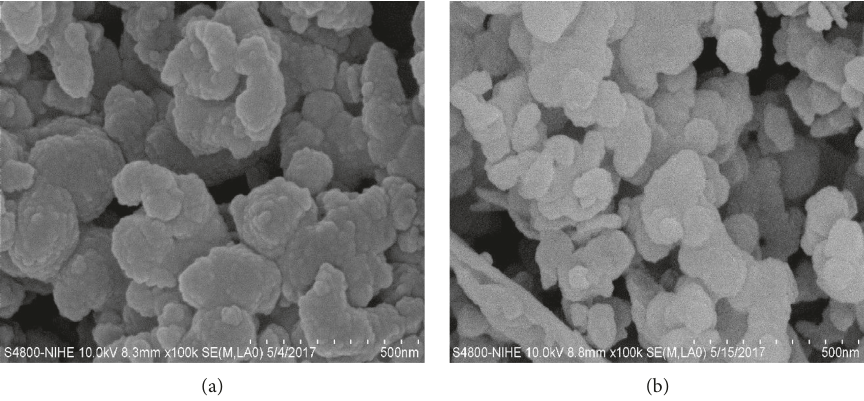
Figure 2: SEM images of (a) Al-MCM-41 and (b) Al-MCM-41@0 1Ag/TiO